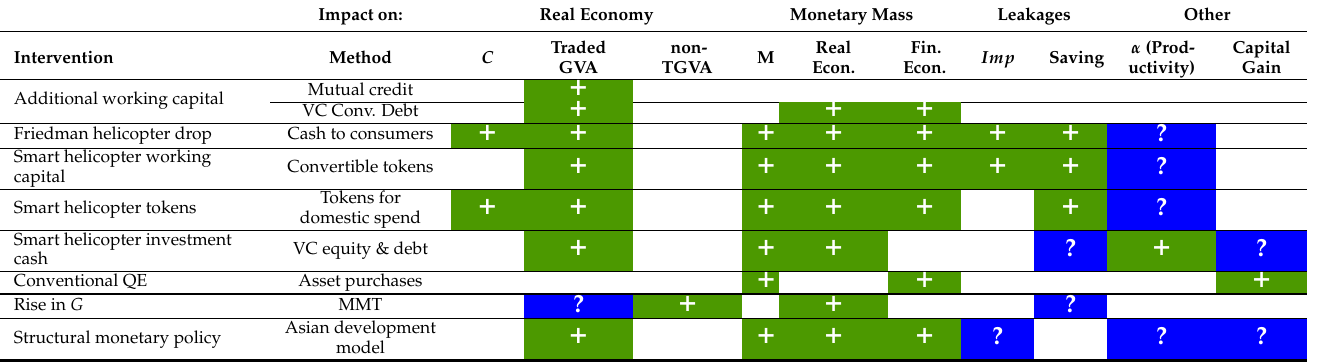
Table 6. Impacts of different monetary policy